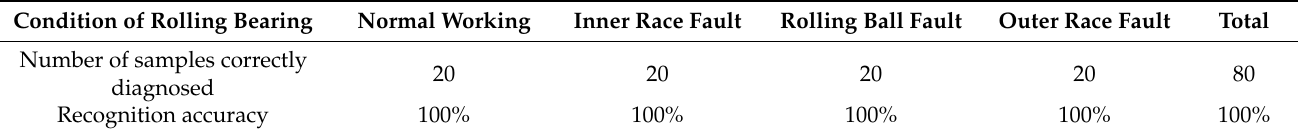
Table 7. Fault diagnosis of rolling bearings based on wavelet kernel extreme learning machine (WKELM). Condition of Rolling